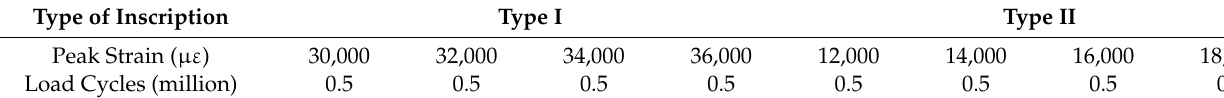
Table 2. Loading regime for Type I and Type II gratings.